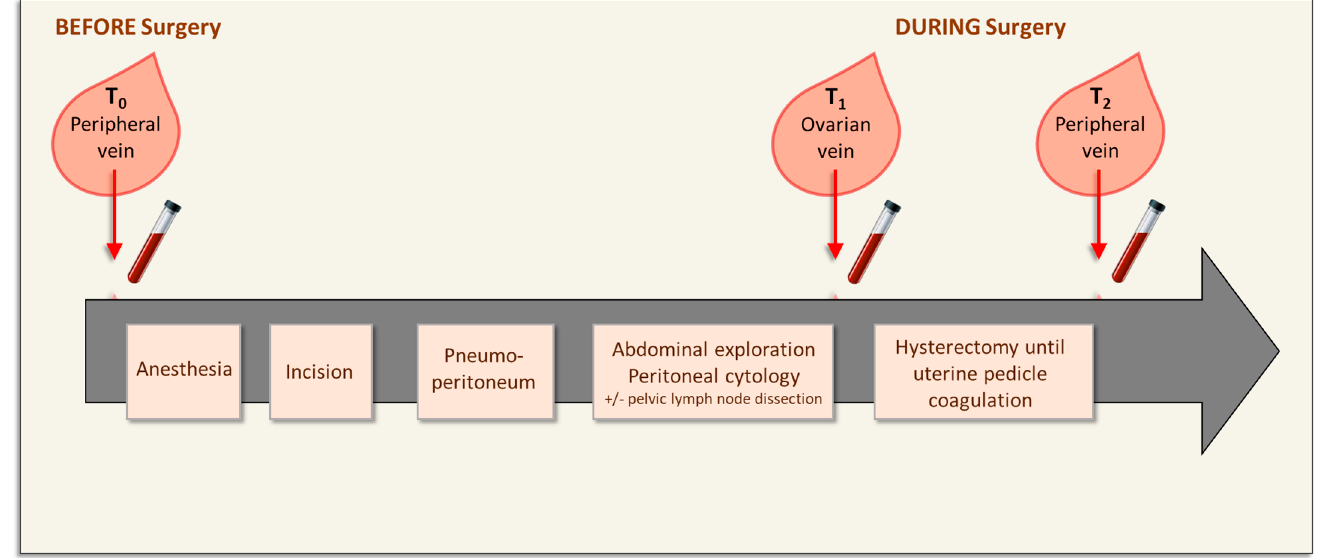
Figure 1. Blood collection before and during surgery of early-stage endometrial cancer . The initial blood sample (T 0 ) was collected from a peripheral vein just before anesthesia and surgery. The other blood samples were obtained during surgery: T 1 (ovarian vein) after pediculation of the ovary suspensory ligament, and T 2 (peripheral vein) after uterine pedicle coagulation.